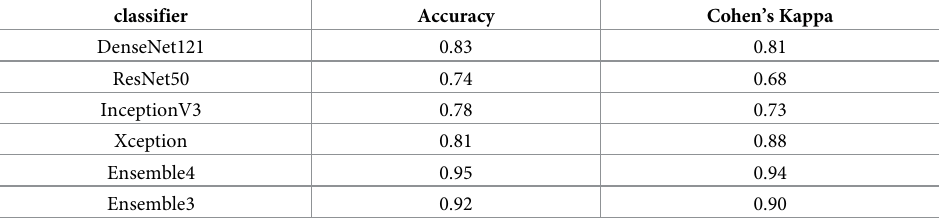
Table 5. Overall accuracy and Kappa values for ensemble classification in comparison to those obtained from indi- vidual classifiers. Ensemble4 combines the results of all four classifiers, whereas ensemble3 does not use the predic- tions from the Xception